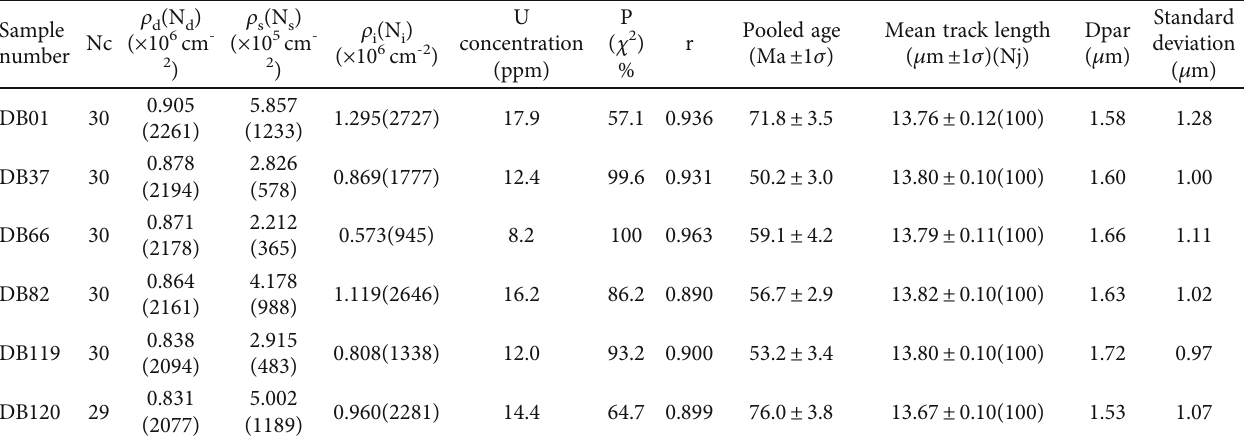
Table 2: Apatite fi ssion track (AFT) results of samples from the Duobaoshan copper deposit. Sample number